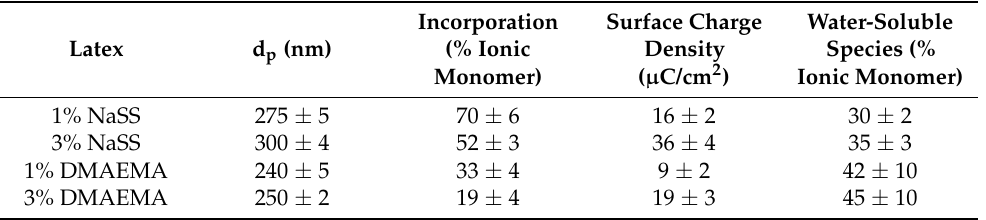
Table 2. Average particle size, surface incorporation of ionic monomer and water-soluble species measurements for anionically and cationically charged